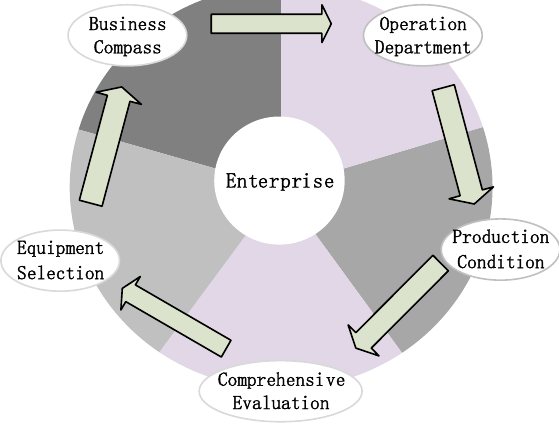
Figure 2. Production equipment selection model.